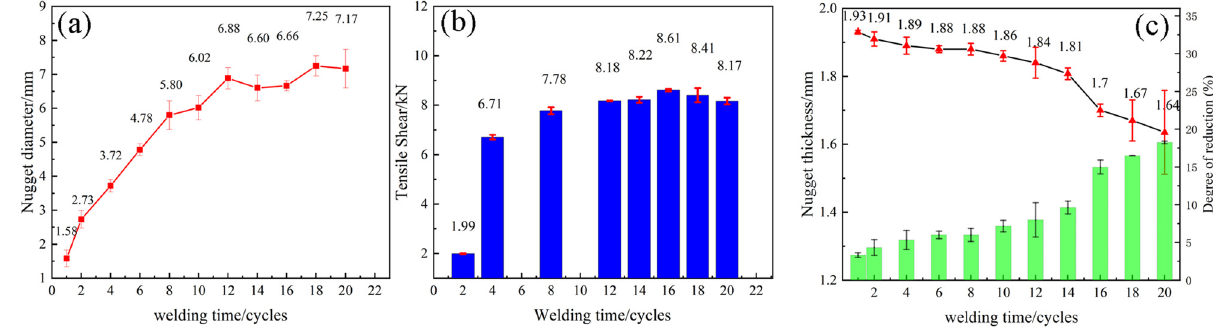
Figure 13: The mechanical property in di ff erent welding times: ( a ) nugget diameter, ( b ) tensile - shear thickness, and ( c ) nugget